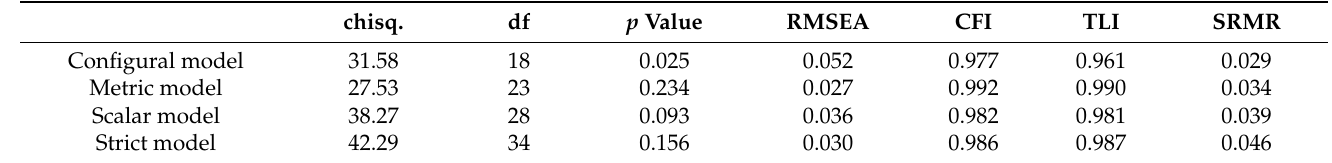
Table 6. Measurement invariance steps across gender.